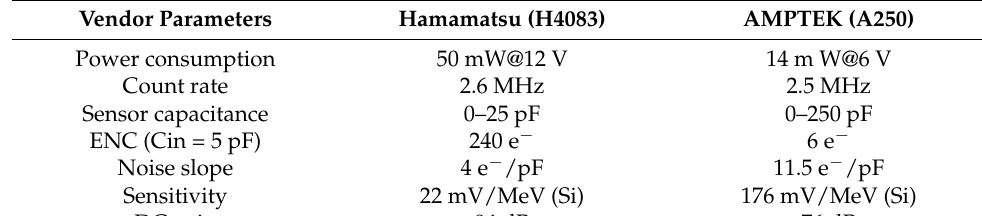
Table 1. Required CSA specifications for silicon sensors for two vendors [6].